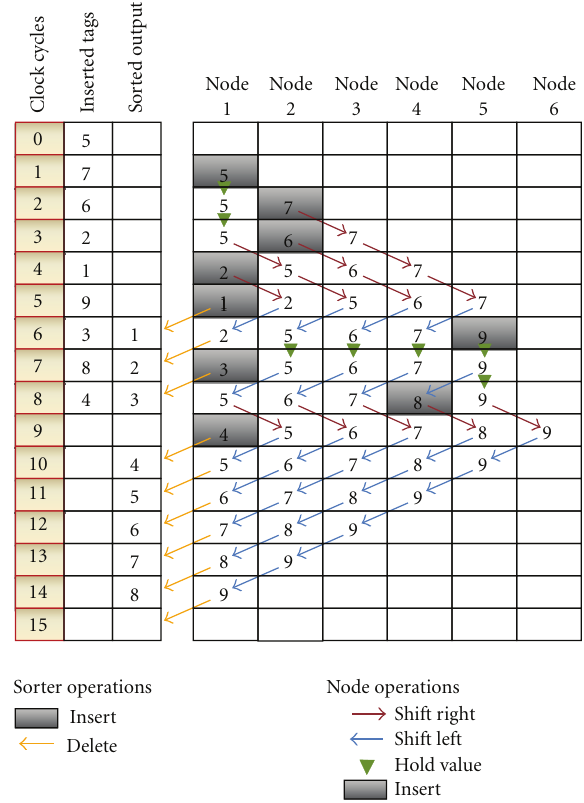
Figure 6: Sample execution of modified linear sorter.